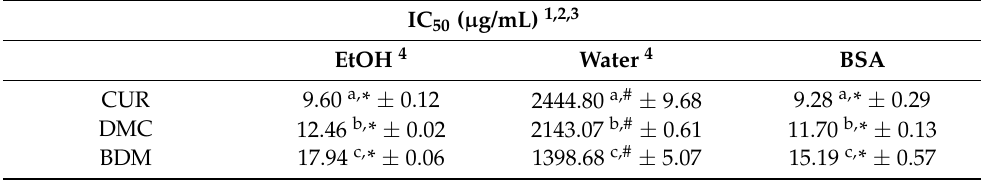
Table 3. Antioxidant activity of free and curcuminoids CUR-, DMC-, and BDM-loaded